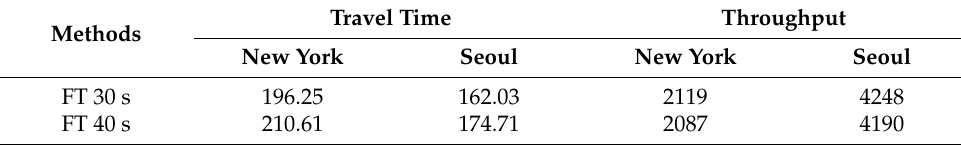
Table 6. Performance comparison of different methods on real-world